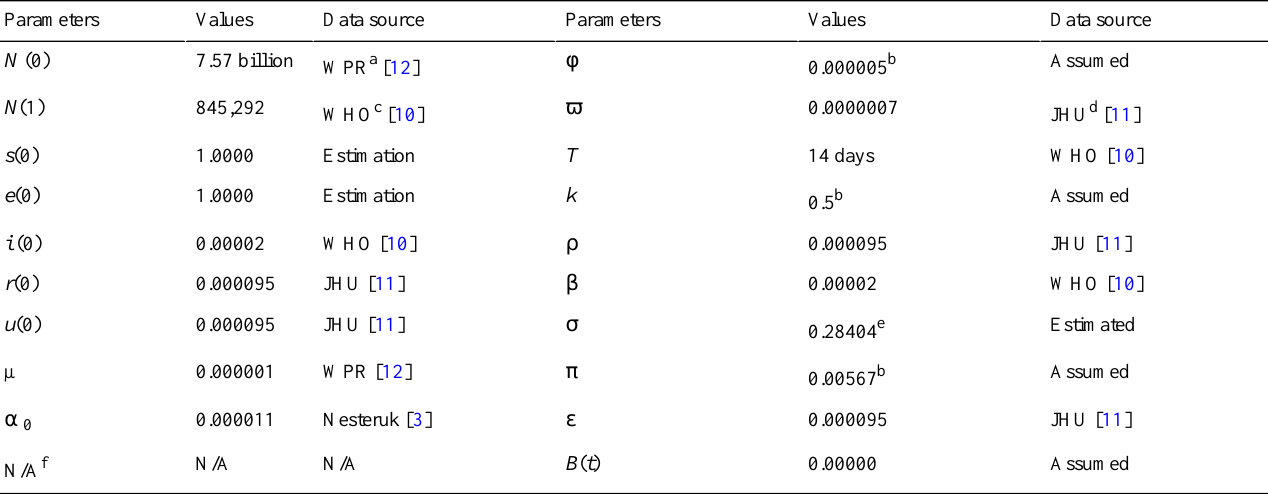
Table 3. Estimated values of the parameters used in the numerical experiments.